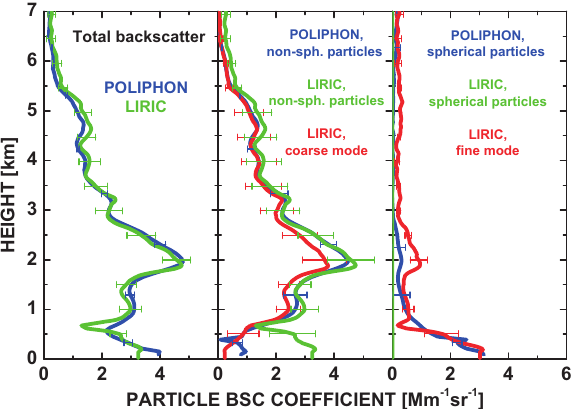
Fig. 4. Comparison of LIRIC- and POLIPHON-derived parti- cle backscatter coefficients observed on 29 May 2008. The blue POLIPHON curves are taken from Fig. 2 of Ansmann et al. (2012). The error bars indicate the uncertainties of the retrieval products as discussed in Sect. 3.1 (LIRIC) and in Ansmann et al. (2011a, 2012) (POLIPHON). Fig. 3. Mean particle optical parameters (left: backscatter coef- ficient, center: extinction coefficient) for three laser wavelengths, backscatter coefficient for the cross–polarized 532 nm lidar channel (left, 532c nm, dark green), and particle volume concentration pro- files (right) for fine–mode and coarse–mode fractions retrieved with the LIRIC method based on the lidar observations on 29 May 2008 shown in Figure 2. The vertical resolution is 15 m. The reference = 9 km and the minimum measurement height height is set to z N = 150 m. is z The error bars show the uncertainties (standard N 0 deviation) of the LIRIC results (see discussion in section 3.1).